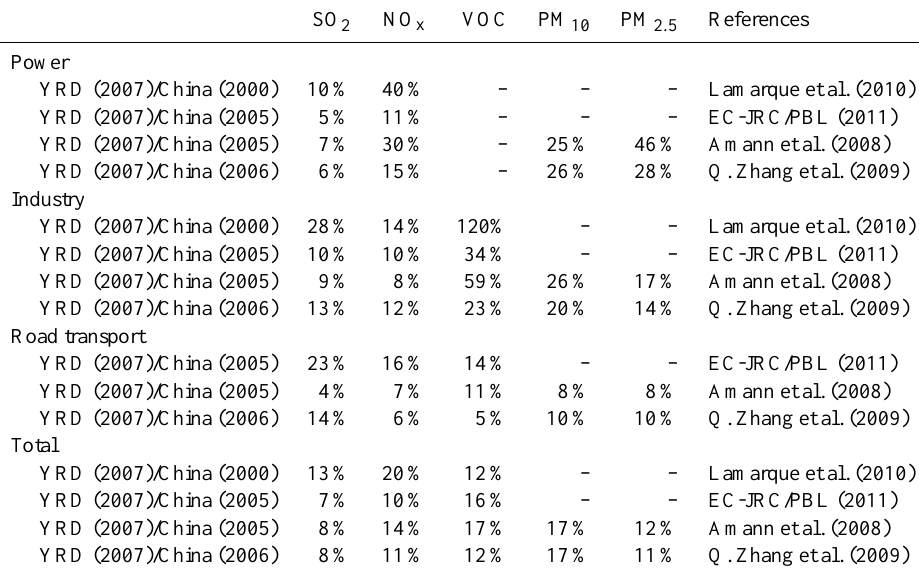
Table 7. Emission contributions of the YRD region to the whole